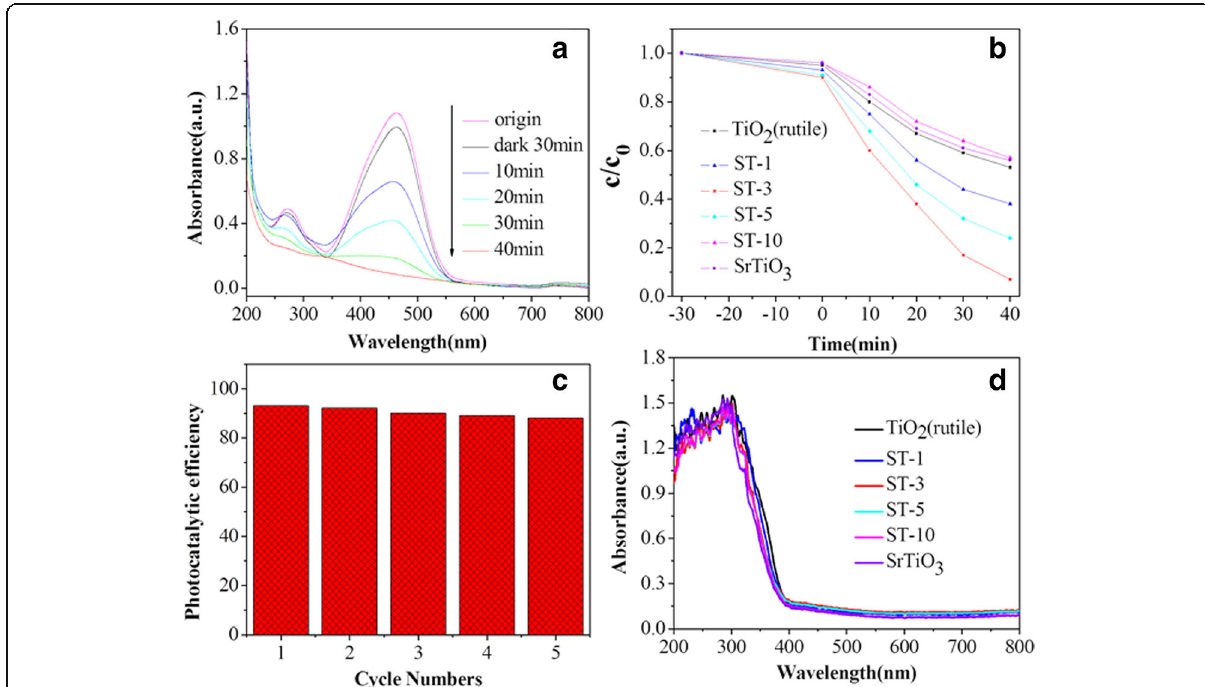
Fig. 5 Photocatalytic activity surveying of different samples. a Absorption spectra of ST-3 in photocatalysis, ( b ) Curves of photocatalytic degradation with different products, ( c ) Recycling of the ST-3, ( d ) The UV – Vis spectra of different products